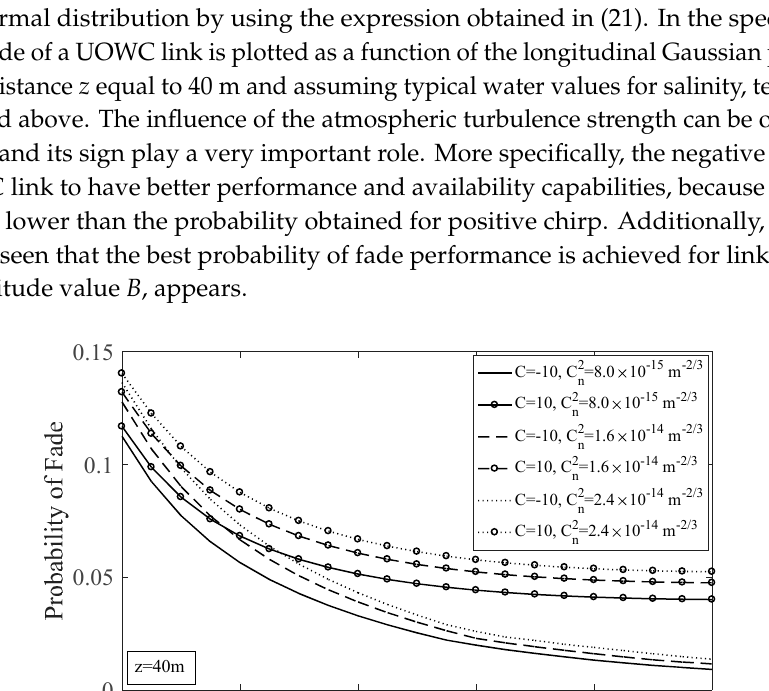
Figure 2. Width of the optical pulse, i.e., T pw , as a function of the propagation distance, z .